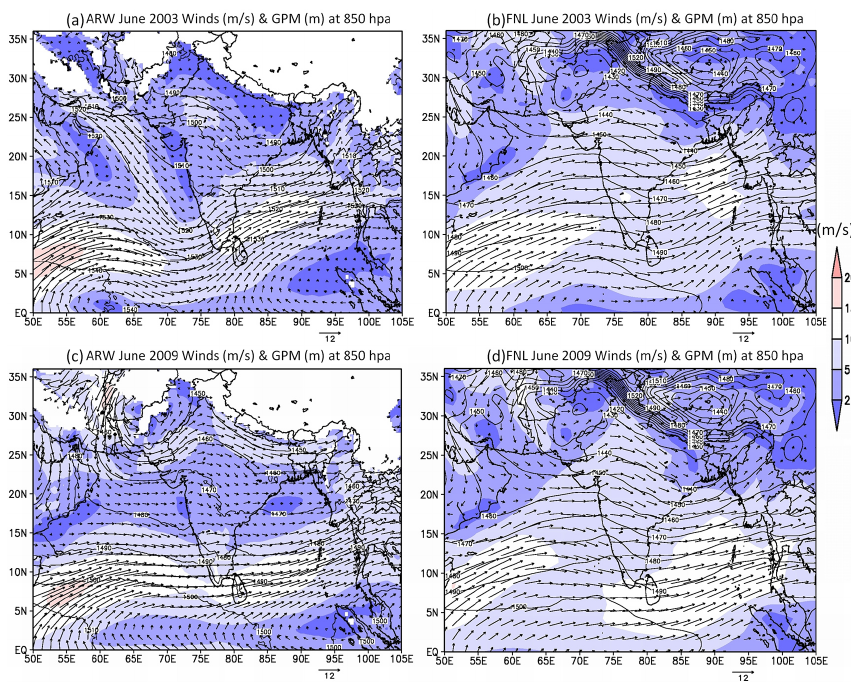
Figure 6. Mean winds (ms − 1 ) and mean geopotential (m) for June for the years 2003 and 2009. The left panels (a, c) are from the ARW model and the right panels (b, d) are from FNL analysis. The top panels are for the year 2003 and the bottom panels for the year 2009.